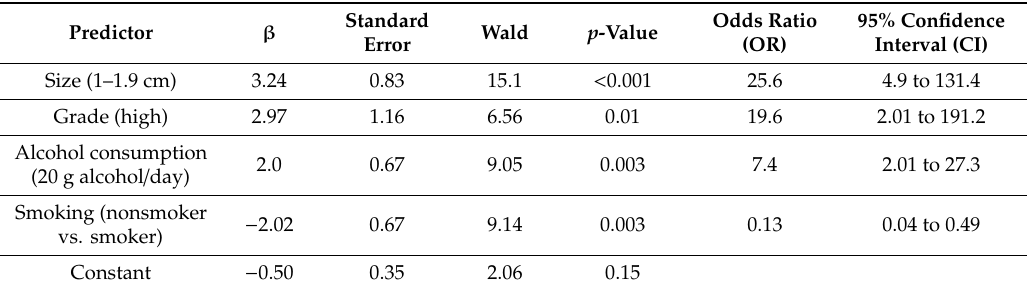
Predicting the probability of developing advanced adenomas (multivariate logistic regression—stepwise